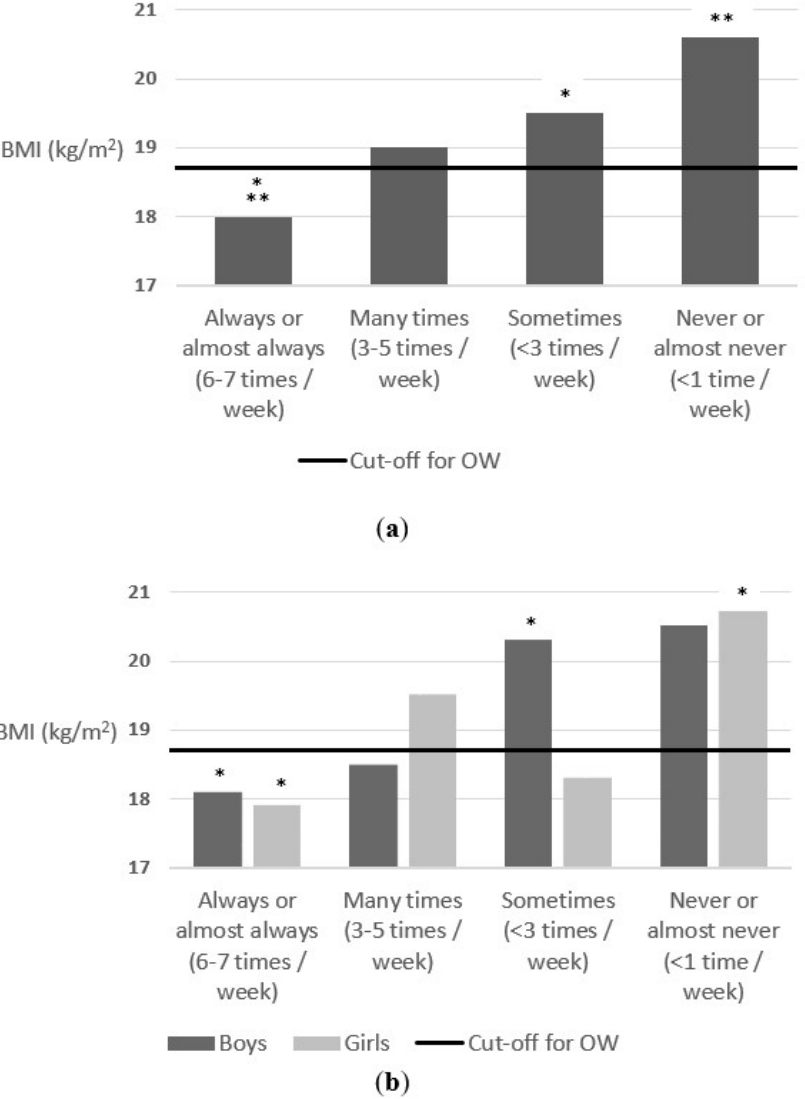
Figure 1. ( a ) Association between breakfast frequency and body weight status (parents reported); ( b ) Association between breakfast frequency and body weight status (parents reported) segmenting by sex. The cut ‐ off for OW line indicates the beginning of the OW category according to Cole’s cut ‐ off points [44]. * p ‐ value < 0.05 and ** p ‐ value < 0.01.